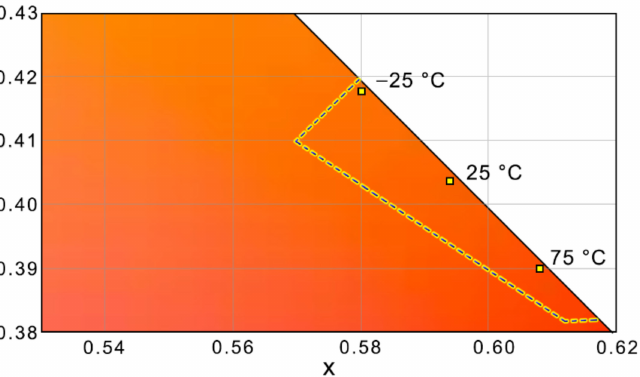
Figure 7. CIE chromaticity areas for yellow aspects of the Italian railway signaling and chromatic coordinates vs. temperature of LY E6SF-DA-6-5A. The chromatic coordinates were calculated using the software LED ColorCalculator